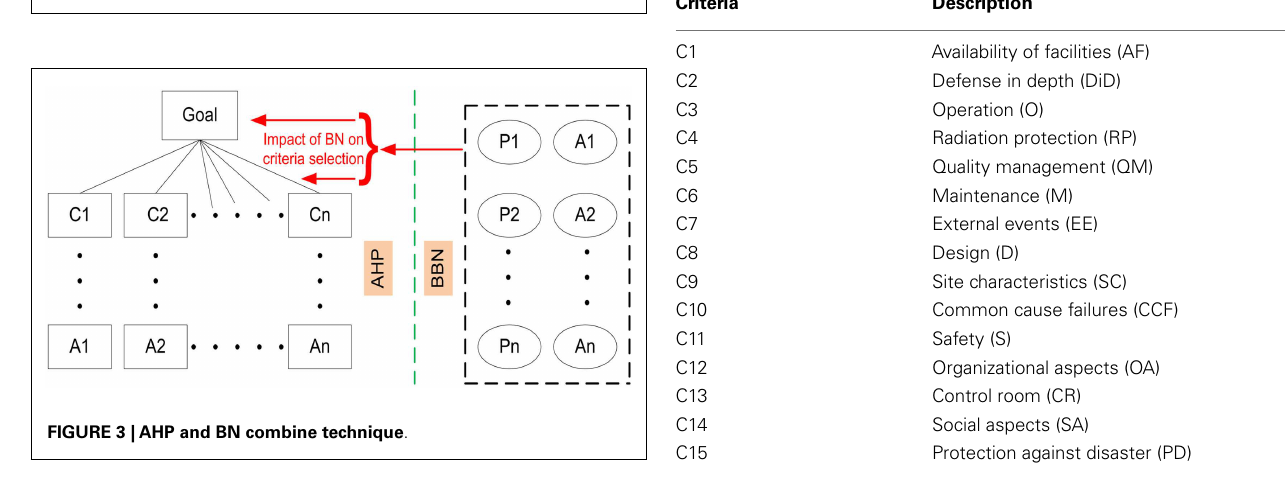
FIGURE 2 | BN network association with criteria .